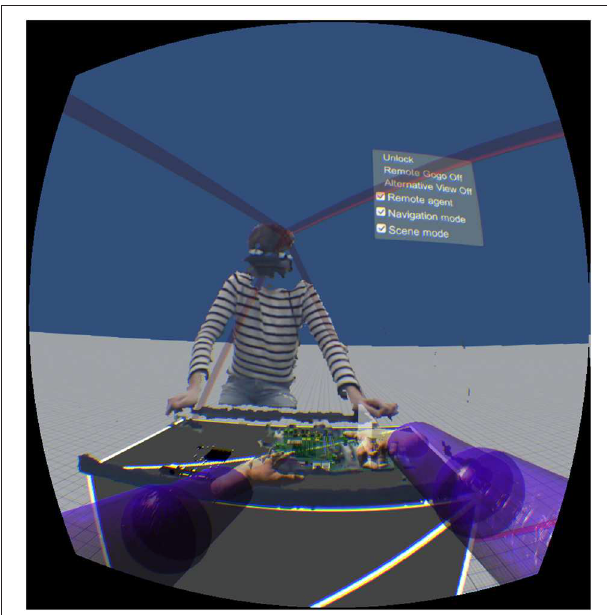
FIGURE 4 | Illustration of the remote expert’s viewpoint, in front of the distant agent (3D reconstruction).